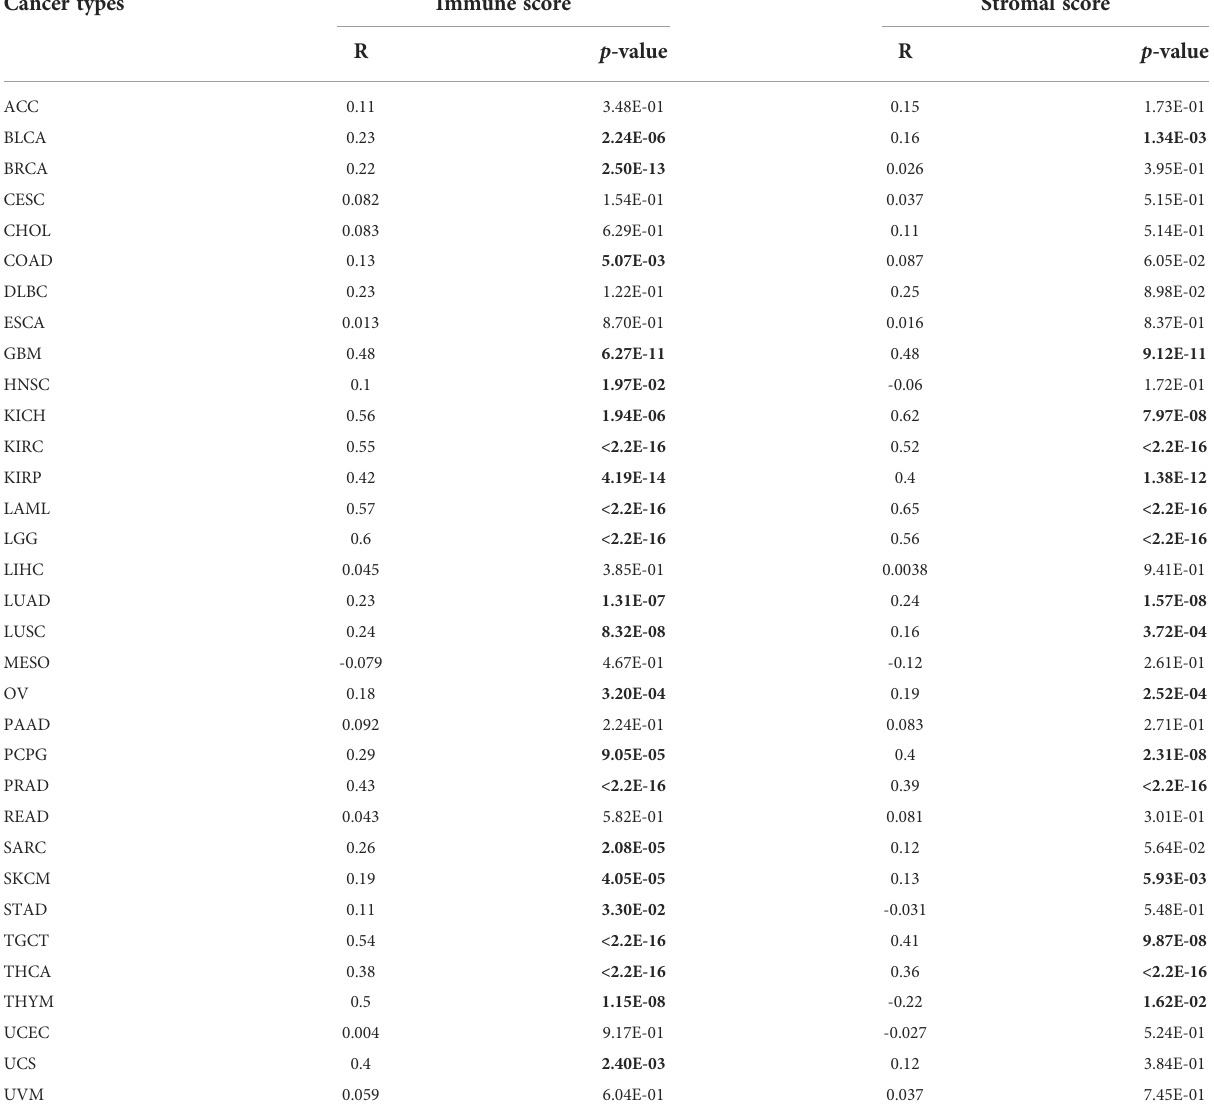
TABLE 2 The correlation between ARPC5 expression and immune scores and stromal scores of tumor microenvironments in pan-cancer. Cancer